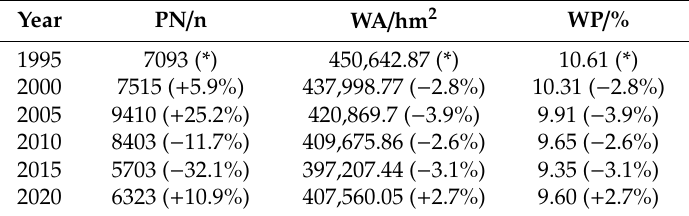
Table 3. Patch number (PN), wetland area (WA), and wetland percentage (WP).